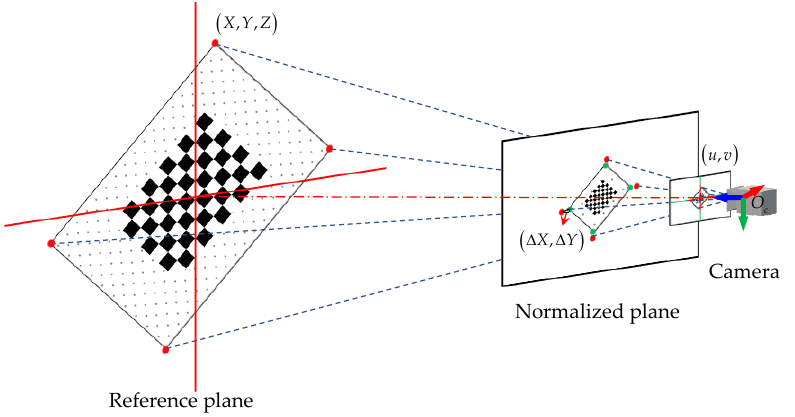
Figure 12. Schematic diagram of the re-projection error of the normalized plane.